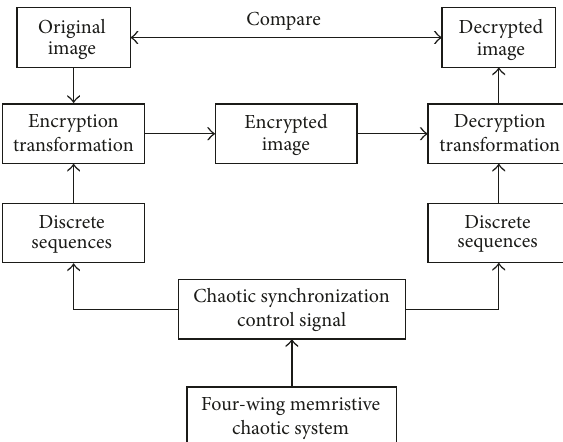
Figure 11: Encryption and decryption flow chart.